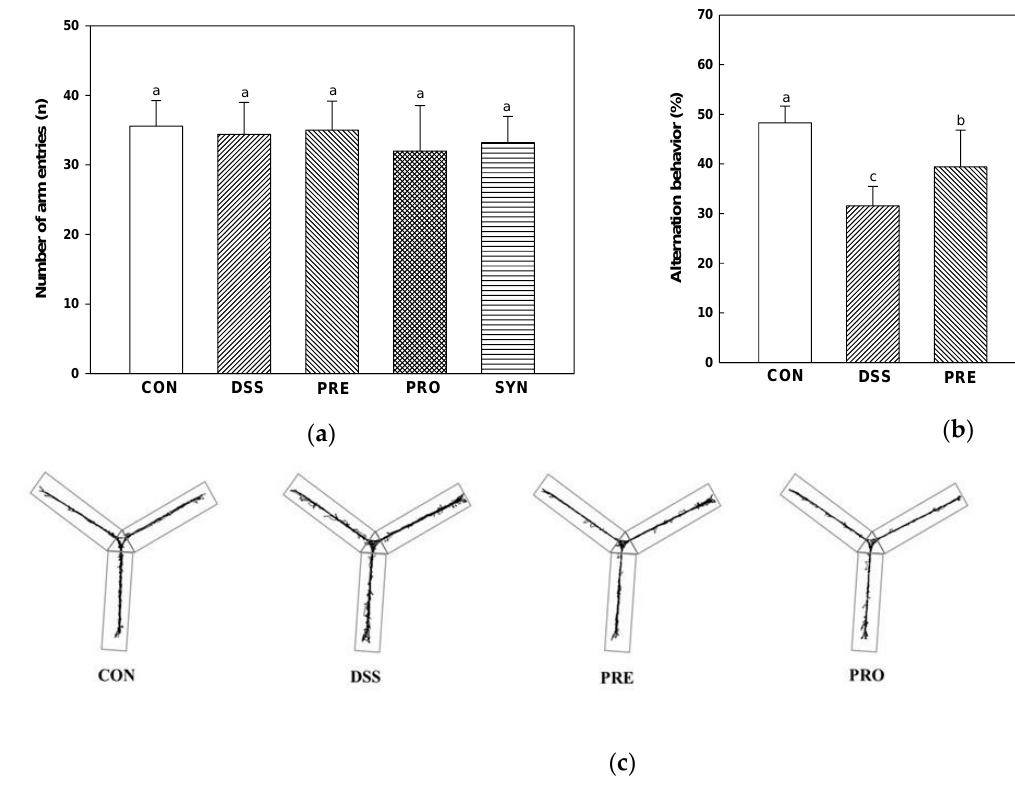
197 198 Table 2. Effect of PRE, PRO, and SYN on concentration of short-chain fatty acids (SCFAs) concentration in DSS-in-